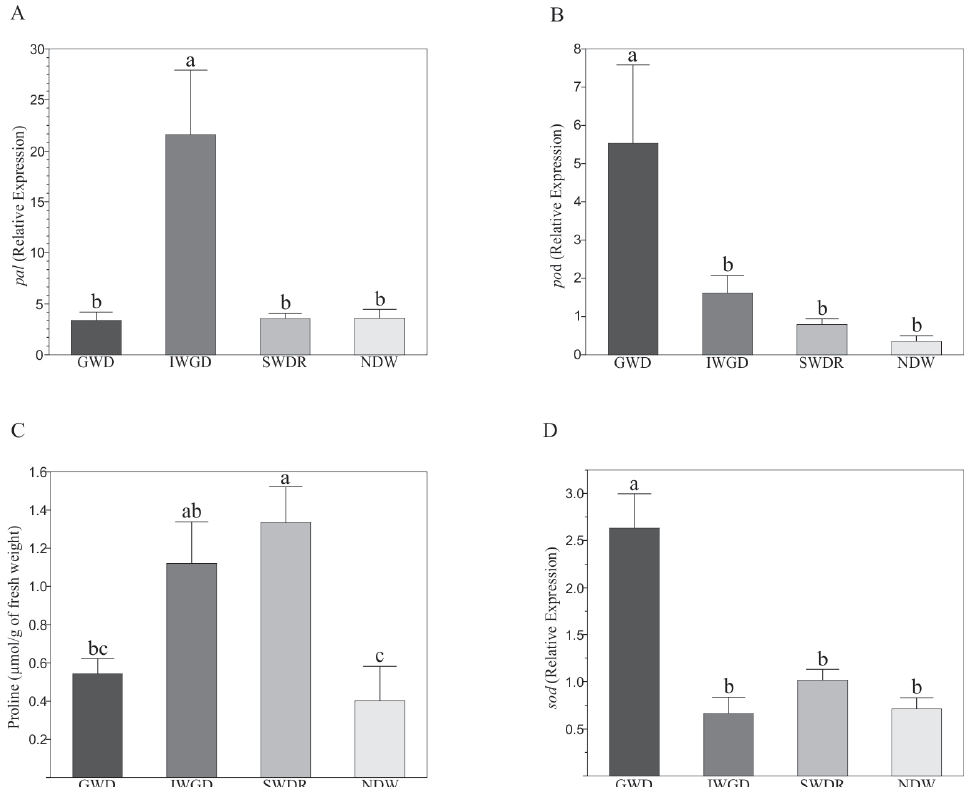
Figure 6. Results of proline accumulation and gene expression associated with the stress response in chili pepper plants grown under different water stress regimes. Results of the comparison of means ± S.E. by using Tukey ′ s test of the biochemical variables. ( A ) Phenylalanine ammonia-lyase ( PAL ); ( B ) Peroxidase ( POD ); ( C ) Proline; ( D ) Superoxide dismutase ( SOD ), with the response in both types of soil added. In all cases, p ≤ 0.05. Gradual water deficit (GWD), initial waterlogging with gradual water deficit (IWGD), sudden water deficit with gradual recovery (SWDR). No deficit of water (NDW).